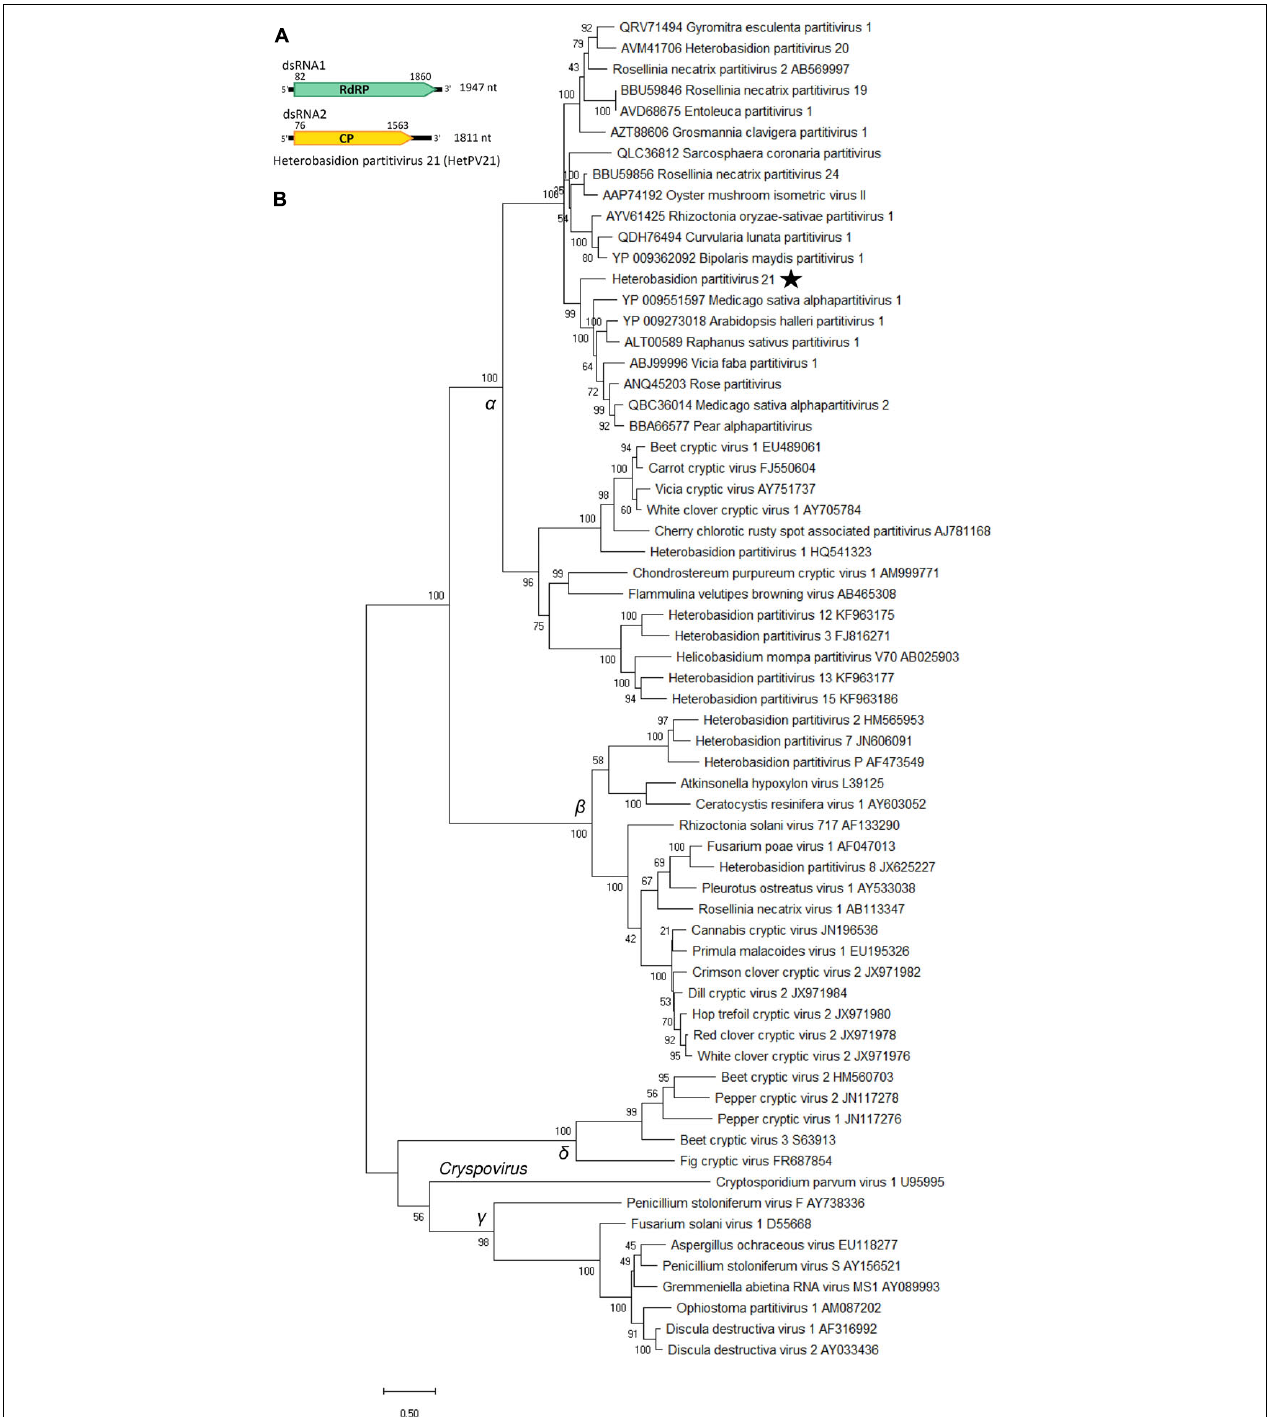
FIGURE 5 | Genome organization of Heterobasidion partitivirus 21 (HetPV21) and phylogenetic analysis of partiti- and related virus strains. (A) Schematic presentation of HetPV21 genome with UTRs and predicted ORFs with translation initiation and termination sites. (B) Phylogenetic tree including members of family Partitiviridae (accession number after virus name) and related unclassified virus strains (accession number before virus name) based on an alignment of aa sequences of the RdRP encoding ORF generated using MAFFT v7.450 with Blosum62 substitution matrix. Evolutionary analyses were conducted in MEGA X (Kumar et al., 2018) with 500 bootstrap repeats (the percentage of trees in which the associated taxa clustered together is shown next to the branches). The evolutionary history was inferred by using the Maximum Likelihood method and Le_Gascuel_2008 model (Le and Gascuel, 2008). A discrete Gamma distribution was used to model evolutionary rate differences among sites (four categories +G +I). A star denotes the virus strain from Heterobasidion parviporum , and Greek symbols indicate the partitivirus genera ( α = Alphapartitivirus , β = Betapartitivirus , γ = Gammapartitivirus , δ = Deltapartitivirus ).